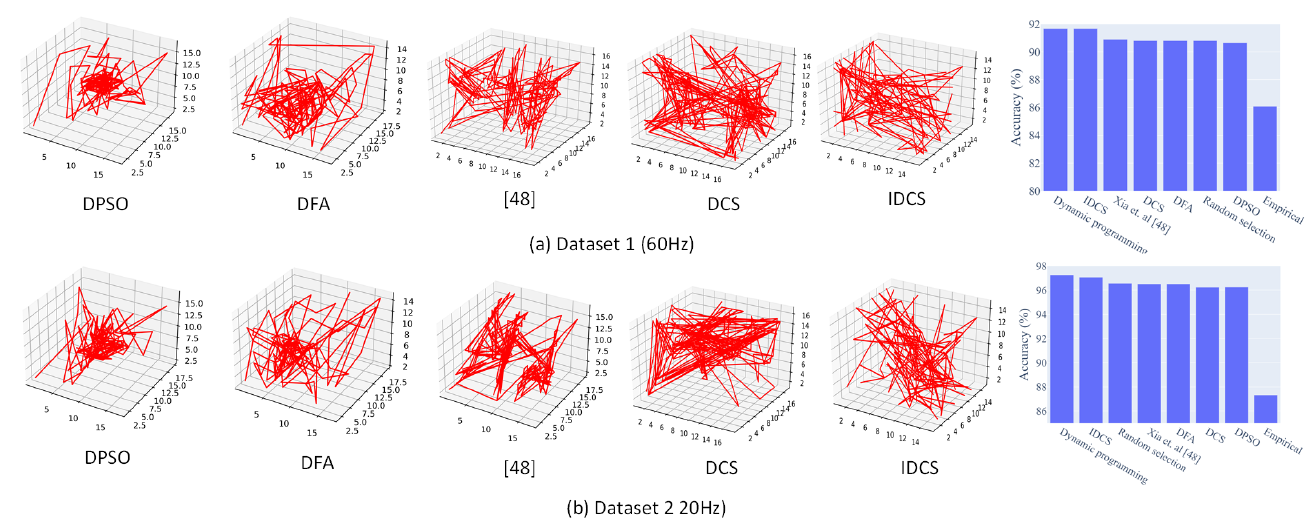
Figure 12. Different heuristic algorithm comparison in Study